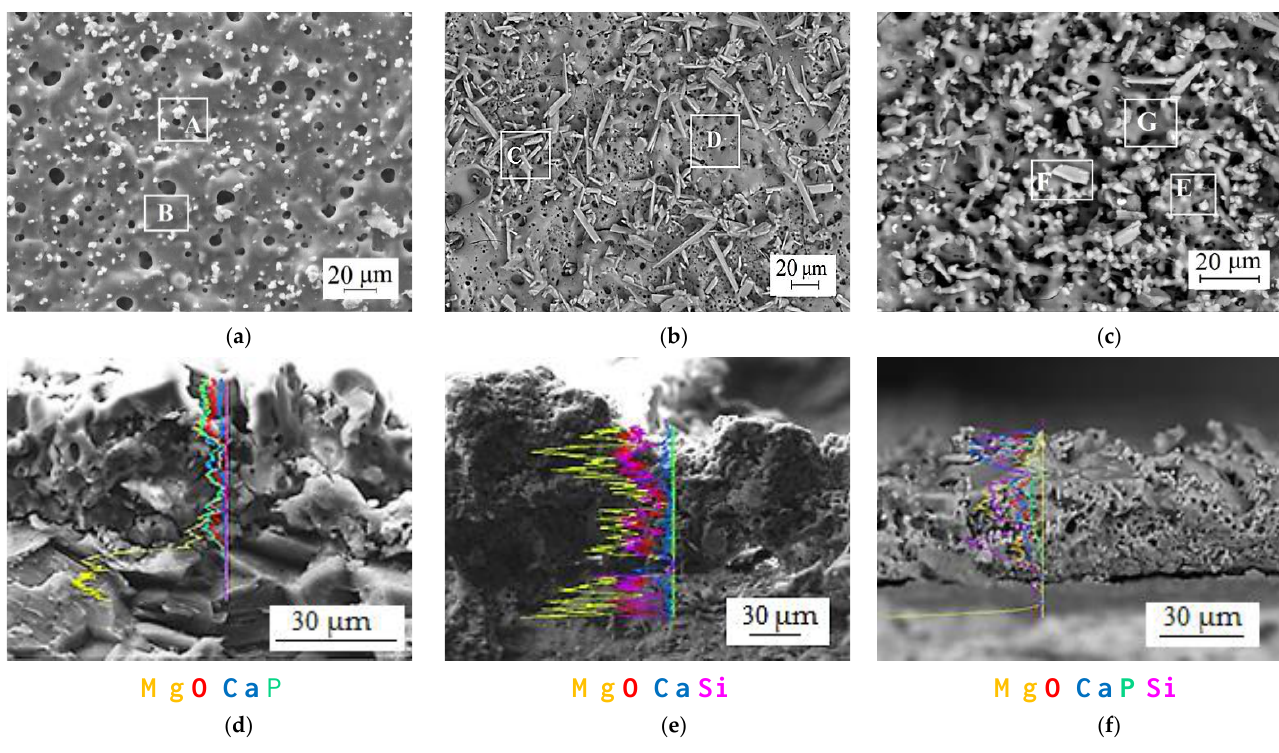
Figure 6. SEM images of the surface of the TC ( a ), WS ( b ), and TW ( c ) coatings with the marked zones; cross-section images of the TC ( d ), WS ( e ), and TW ( f ) coatings with the tracks of the distribution of the elements. Table 2. Elemental composition in the marked zones.